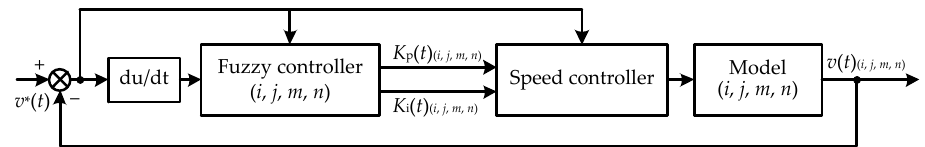
Figure 4. Exclusive fuzzy controller for Model( i , j , m , n ).